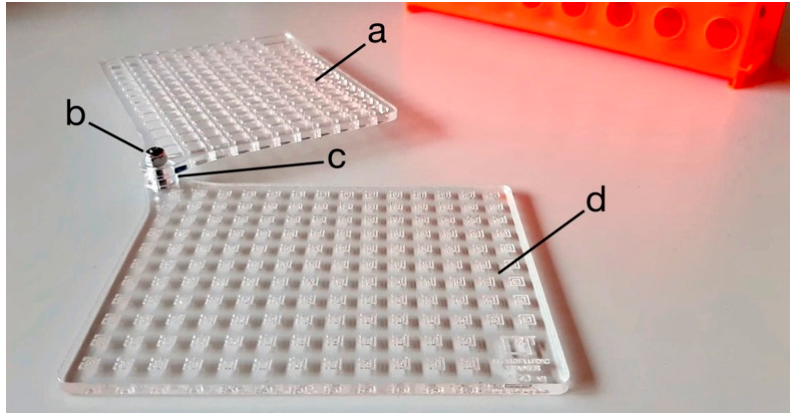
Figure 3. Components of the MT device. Cover grid ( a ), self-locking screw ( b ), spacer ring ( c ), exercise plate ( d ).